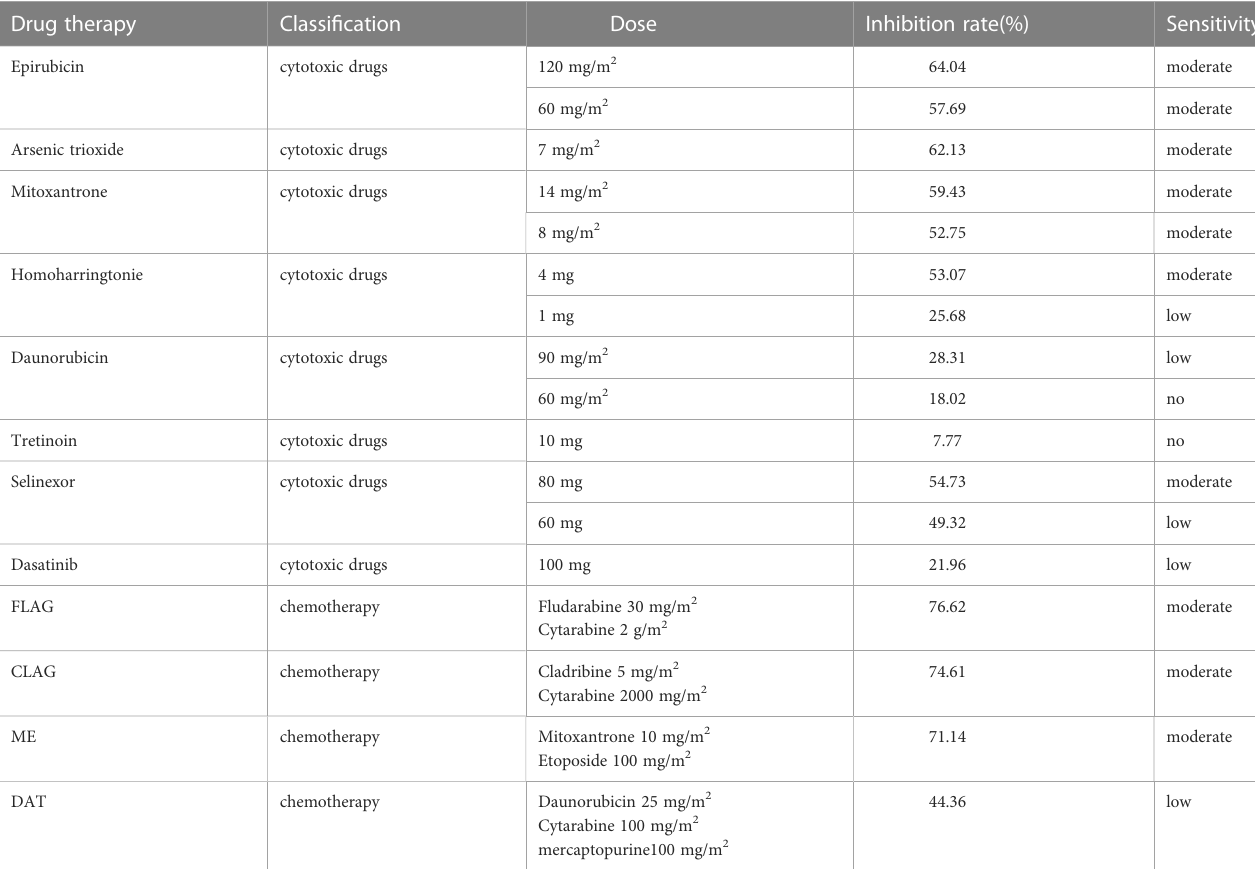
TABLE 2 Evaluating the in vitro chemosensitivity of single drug chemotherapies/chemotherapy regimens to APL with FIP1L1::RARA. Drug